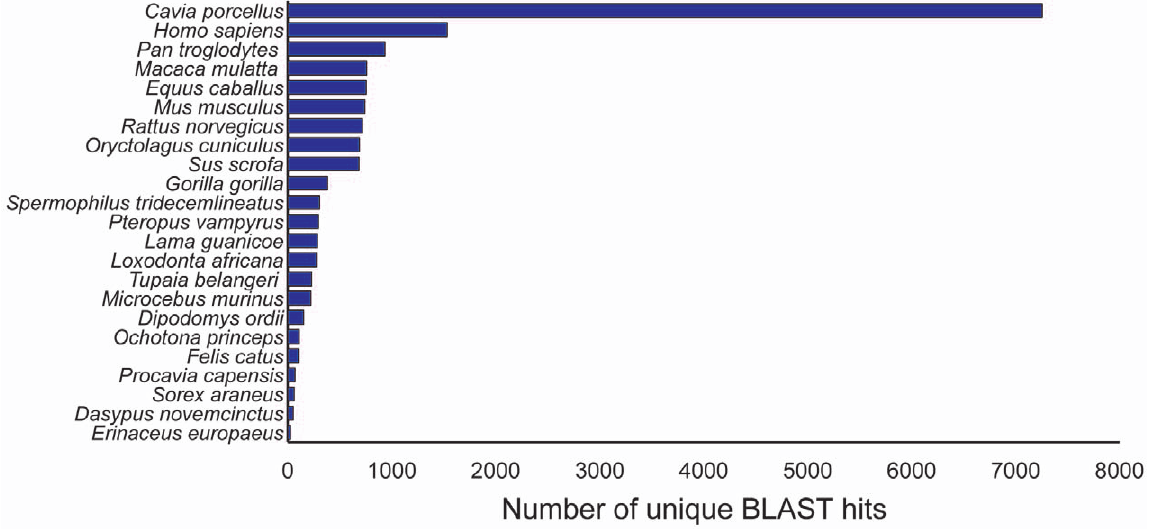
Figure 4. The number of blast hits from 23 mammalian species for which genomes have been sequenced.